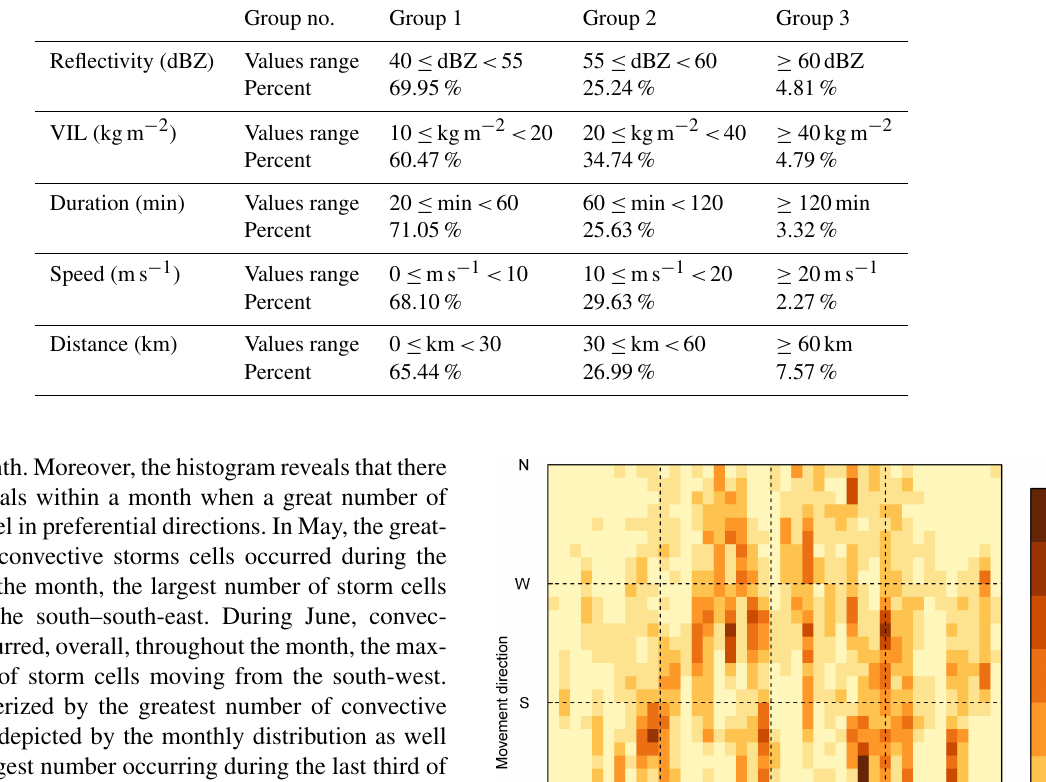
Table 2. Radar-derived parameters of convective storms, range of values, and their associated percentages from the total number of convec- tive storms detected within the Prut River basin. Group no. Group 1 Group 2